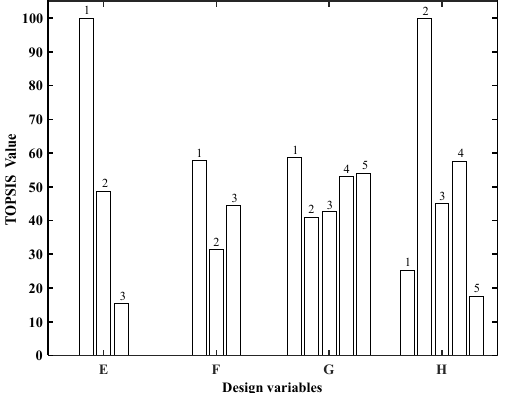
Figure 17. TOPSIS evaluation of duct.